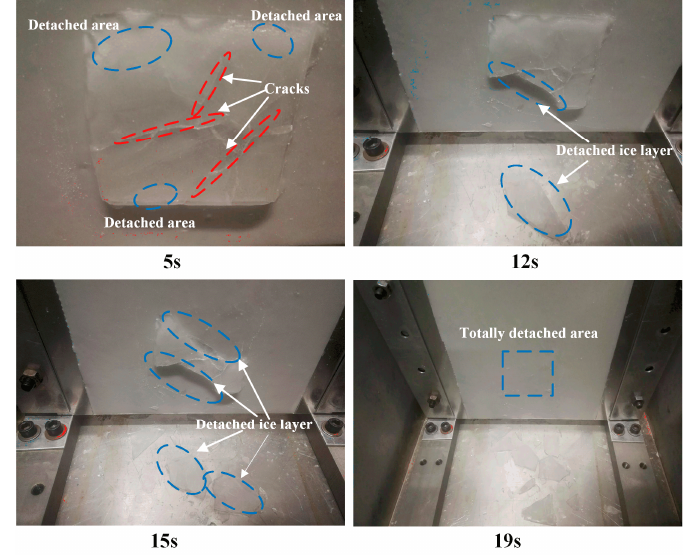
Figure 14. De-icing process for coating with Young’s modulus 302.56 MPa.